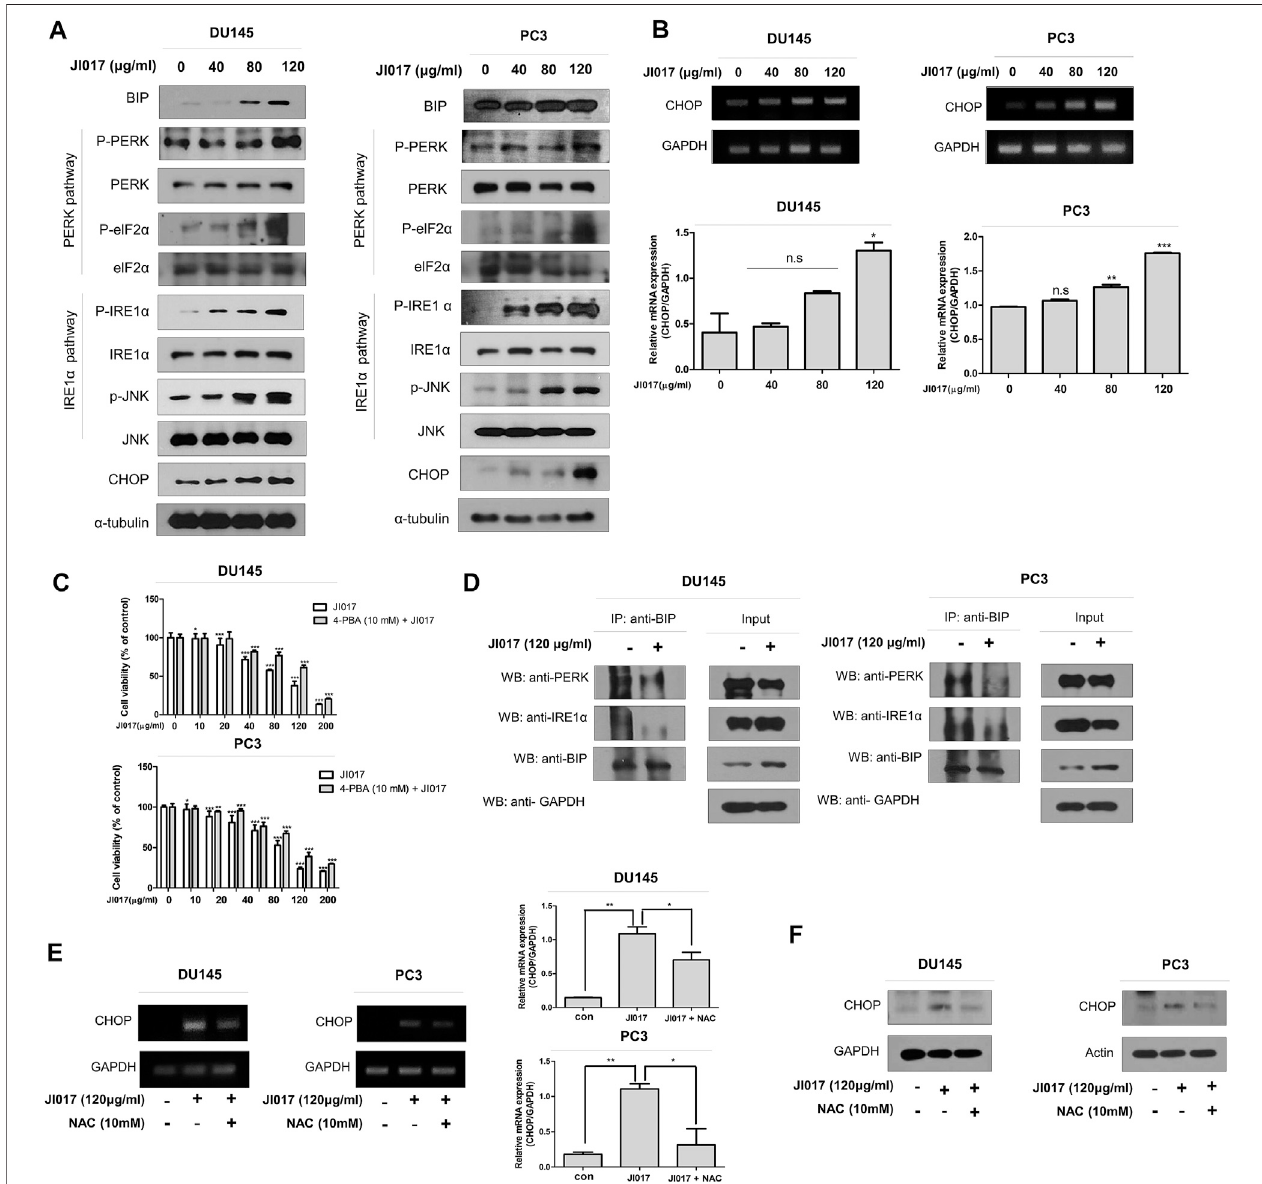
FIGURE 5 | JI017 treatment activated UPR signaling in DU145 and PC3 cells. DU145 and PC3 cells were treated with JI017 (40, 80, and 120 μ g/ml) for 24 h. Whole cell lysates were analyzed by western blotting with anti-GRP78/BIP, anti-p-PERK, anti-p-ELF2 α , anti-p-IRE1 α , anti- p -JNK, anti-CHOP and anti-GAPDH antibodies (A) . The expression of CHOP mRNA was measured by RT-PCR (B) . Pretreatment with 4-PBA (10 mM) for 1 h was followed by JI017 treatment. Cell viability was measured by the MTS assay (C) . DU145 and PC3 cells were treated with JI017 (120 μ g/ml) for 24 h. BIP was immunoprecipitated in DU145 and PC3 cells. Then, the immunoprecipitated proteins were detected by western blotting with anti-PERK and anti-IRE1 α antibodies (D) . Pretreatment with NAC (10 mM) for 1 h was followed by JI017 treatment. Whole cell lysates were analyzed by western blotting with an anti-CHOP antibody (E) . The expression of CHOP mRNA was measured by RT-PCR (F) . The data are presented as the mean ± SEM. * p < 0.05, ** p < 0.01, and *** p < 0.001 compared to untreated